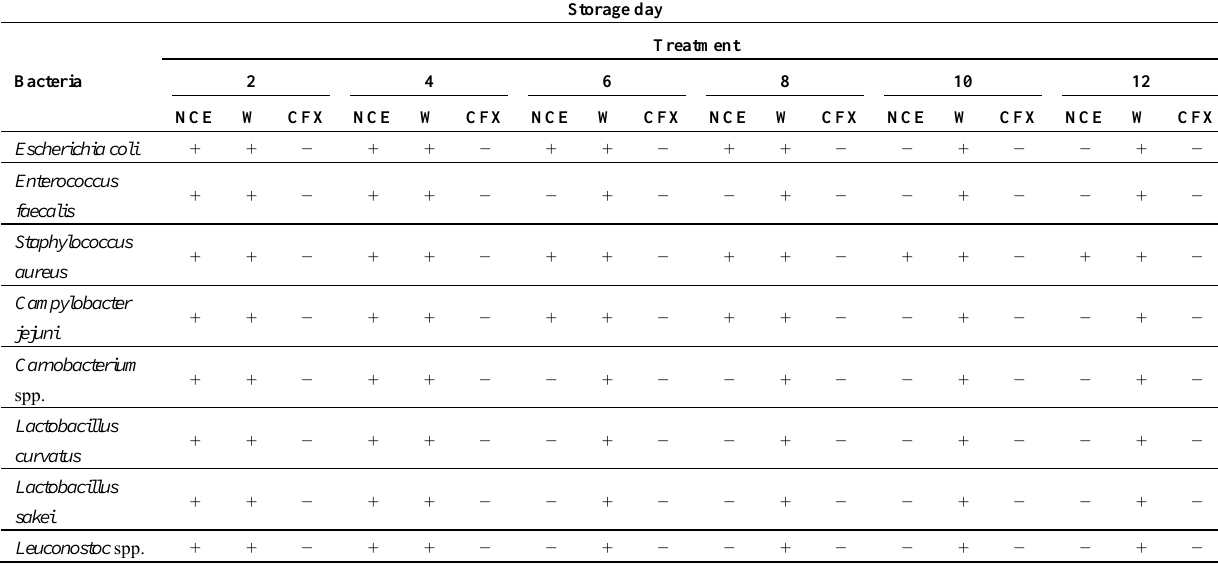
(10/200 µg/µL) of the tested bacterial strain viable cells in vacuum packed minced beef meat stored at 10